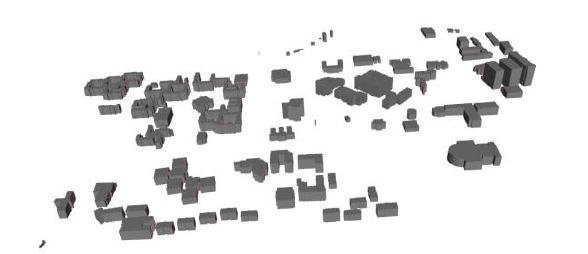
Figure 5. Overview of the generated LoD1 campus model.